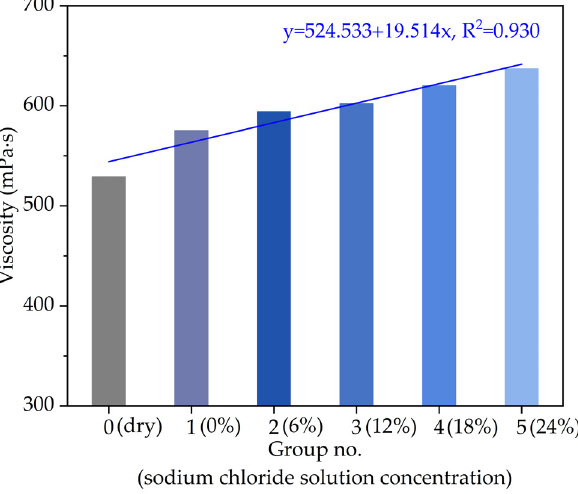
Figure 4. The viscosity variation of asphalt at 135 °C with different chloride salt concentrations.